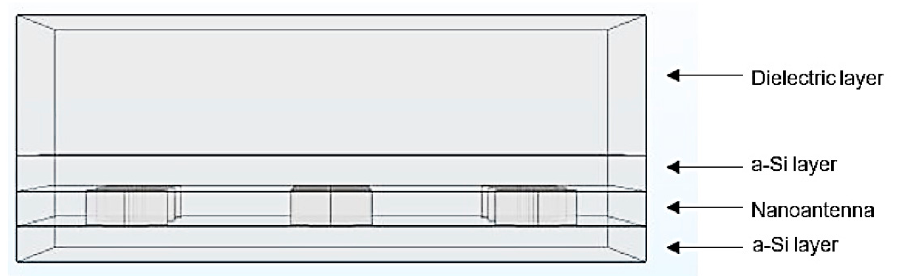
Figure 9. Side view of the 3D a-Si solar cell structure with the nanoantenna inclusion within the solar cell.